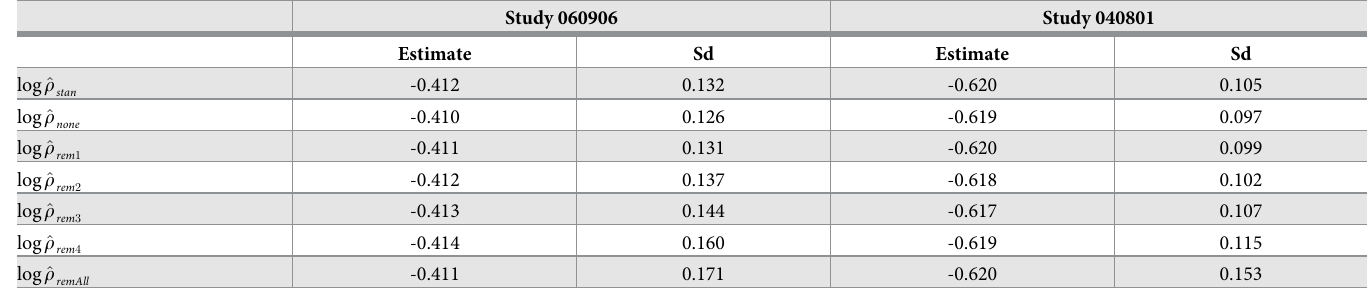
Table 3. Results from the Bayesian analysis based on 1000 simulations. Estimates and standard errors for the relative log-potency of the insulin analogue compared to HI for study 060906 (insulin analogue 32) and 040801 (insulin analogue 7) are shown for different ways of re-fitting the simulated data: none and all indicate keeping and removing all the control rats, respectively, rem1 indicate removing one control rat per dose value, rem2 indicate removing two and so